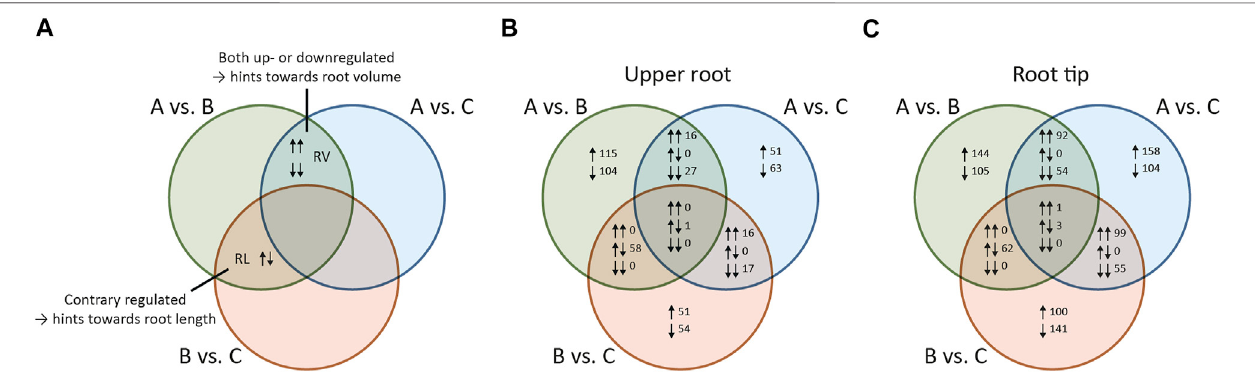
FIGURE 2 | Venn diagram of differentially expressed genes (DEGs) identi fi ed by pairwise comparison of plant pools differing in root morphology. All pairwise comparisons between the pools were set in relation to each other based on log2 fold change values in order to identify shared DEGs (A) Schematic Venn diagram illustrating the identi fi cation ofDEGs related to primary root volume or primary root length (B) Venn diagram showing DEGs identi fi ed by comparison among the pools in theupper root (C) VenndiagramshowingDEGsidenti fi edbycomparisonamongthepoolsintheroottip. PoolA (cid:1) plantswithmedium tolongand thickroots(high value for primary root length and volume in the upper 5 cm of the primary root). Pool B (cid:1) plants with short, thin roots. Pool C (cid:1) Plants with long, thin roots. RV (cid:1) DEGs in fl uencingprimaryrootvolume;R (cid:1) DEGsin fl uencingprimaryrootlength; ↑ (cid:1) DEGswithpositivelog2foldchanges(moreabundantinthe fi rstpoolineachcomparison); ↓ (cid:1) DEGs with negative log2 fold changes (more abundant in the second pool in each comparison); ↑↑ (cid:1) DEGs with positive log2 fold changes for all comparisons (more abundant in the fi rst pool of each comparison); ↓↓ (cid:1) DEGs with negative log2 fold changes for all comparisons (more abundant in the second pool of each comparison); ↑↓ (cid:1) DEGs with opposing log2 fold change values (positive in one comparison but negative in the